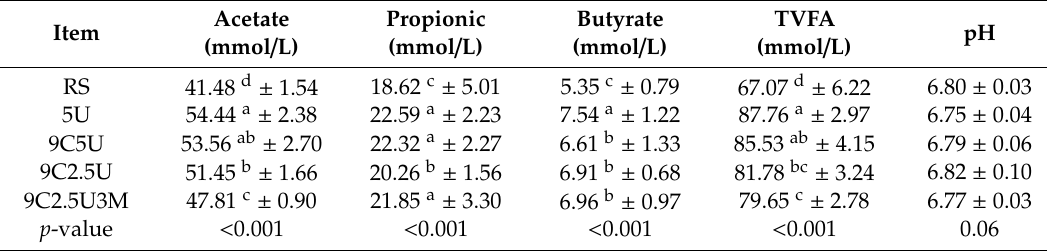
Table 6. E ff ect of ammoniation on in vitro rumen fermentation parameters of rice